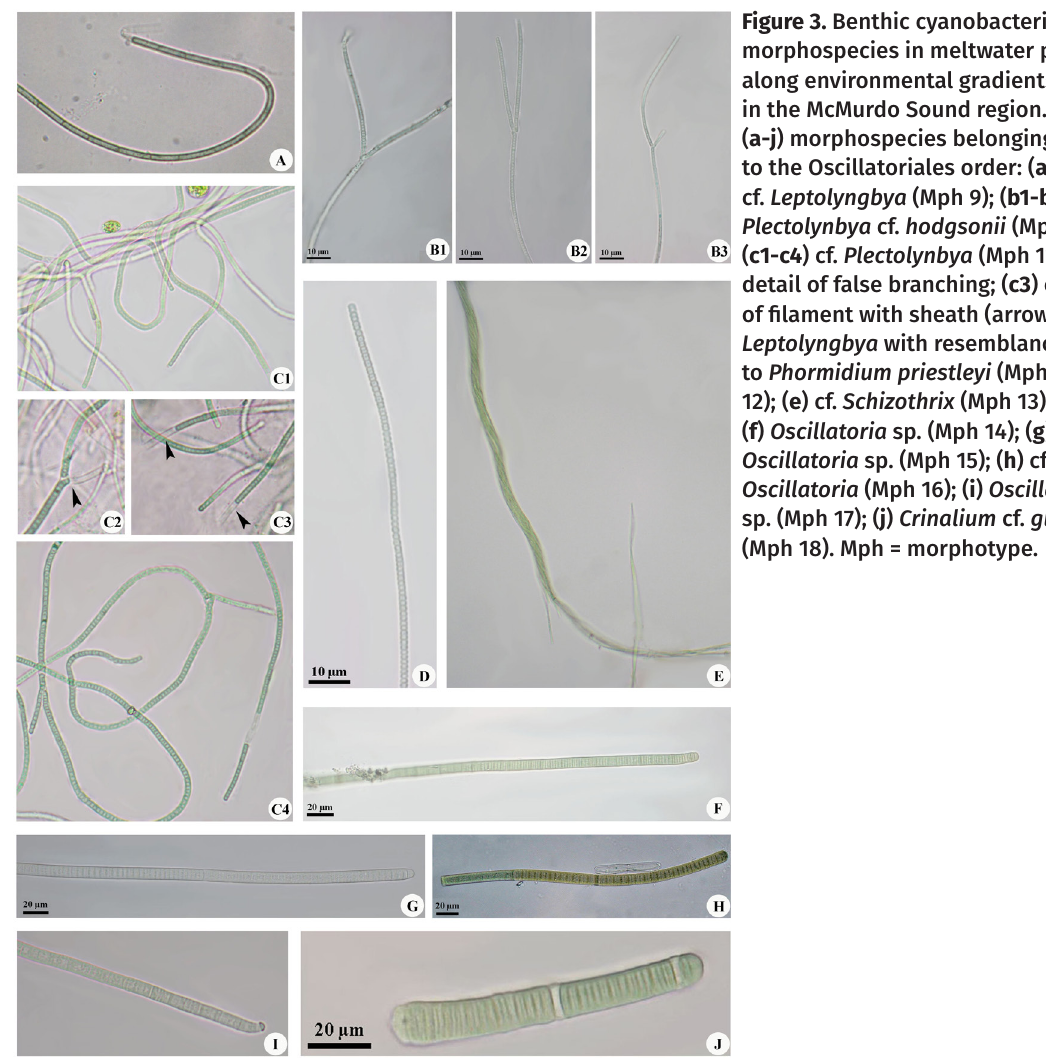
Figure 3. Benthic cyanobacterial morphospecies in meltwater ponds along environmental gradients in the McMurdo Sound